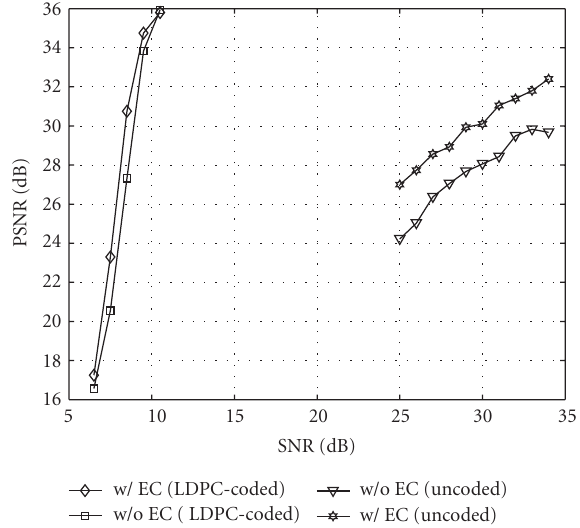
Figure 6: PSNR versus SNR comparison for with and without error concealment schemes.